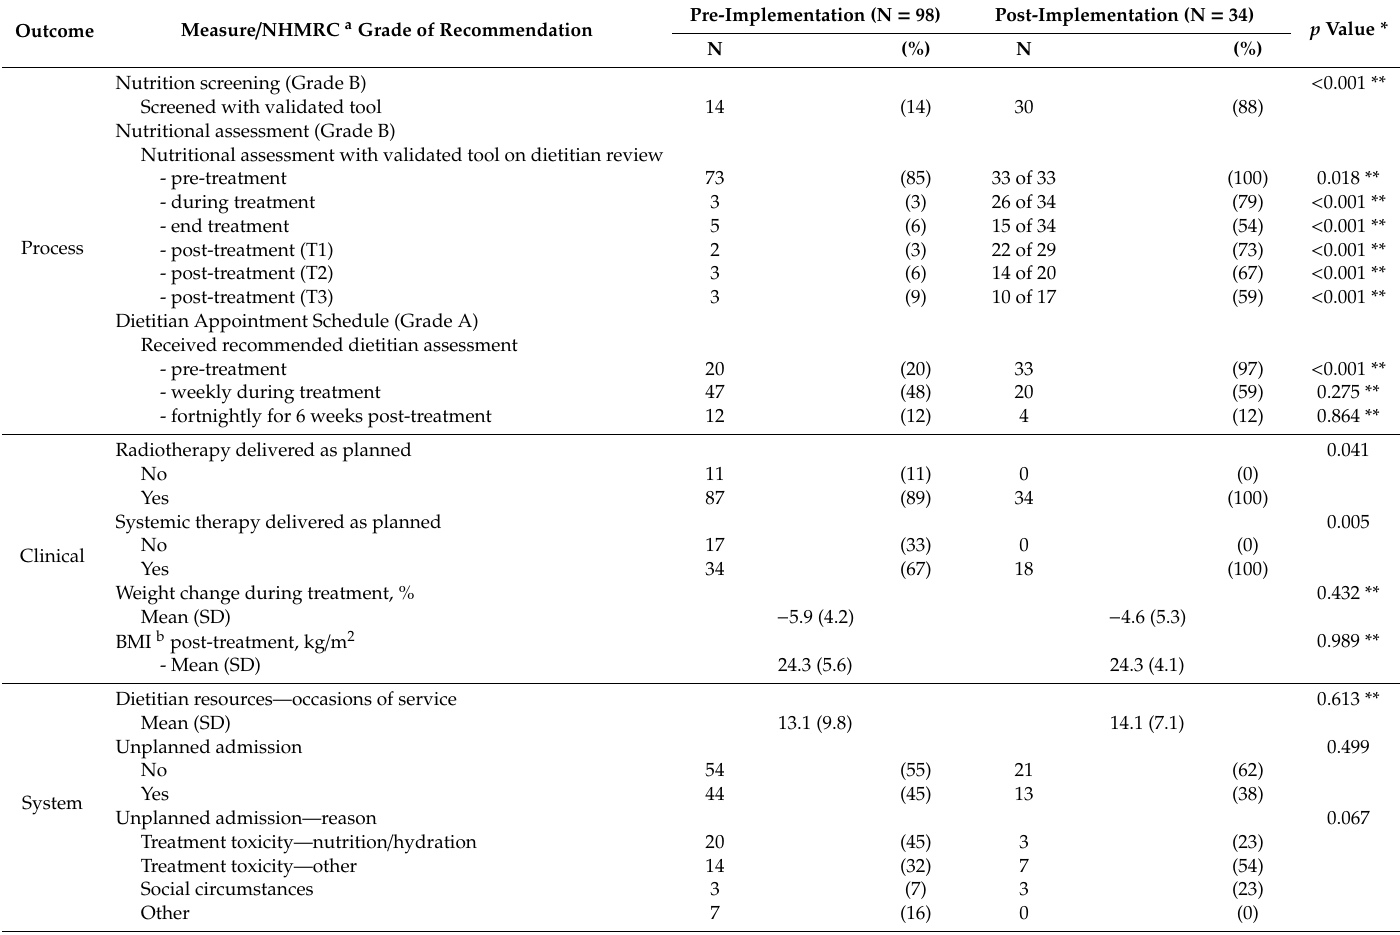
Table 3. Summary of key results—comparison of outcome measures between pre- and post-implementation cohorts. Outcome Measure / NHMRC a Grade of Recommendation Nutrition screening (Grade B) Screened with validated